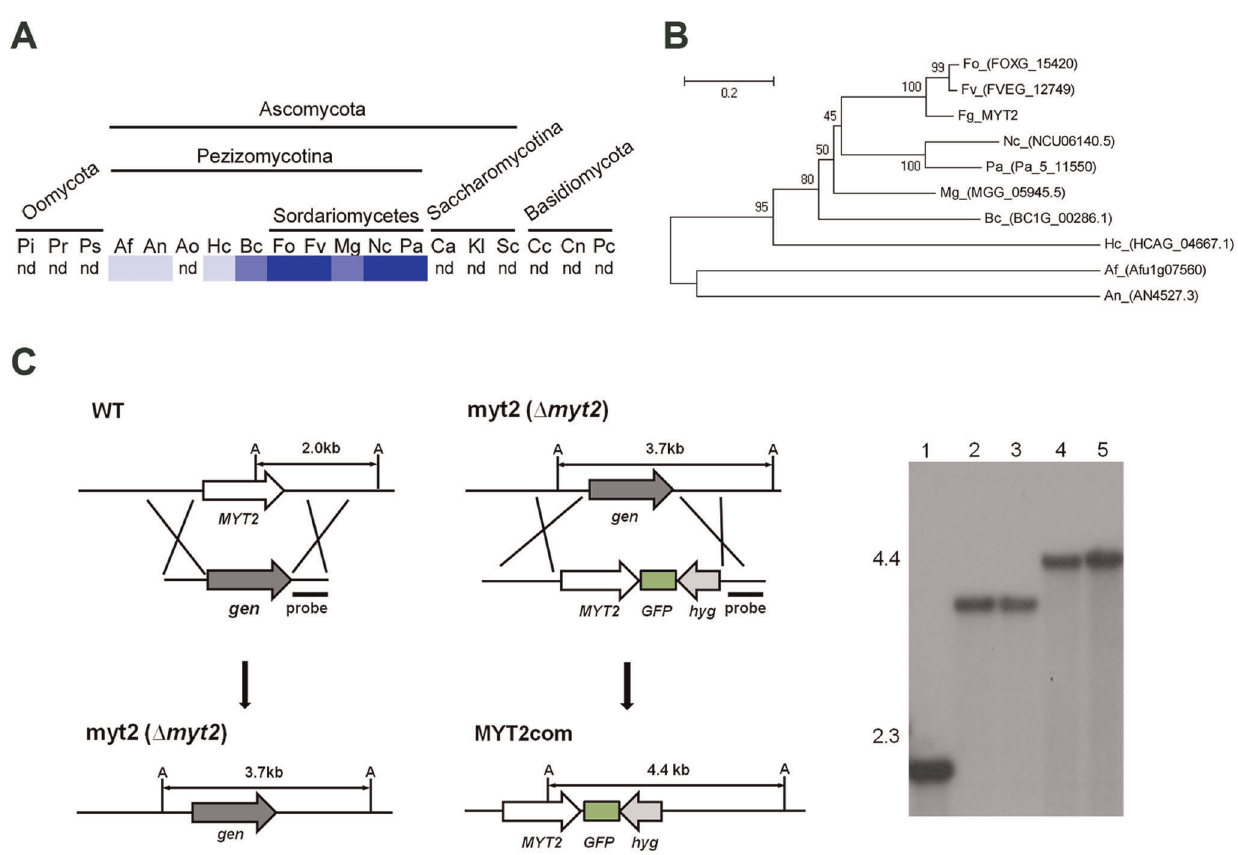
Figure 1. Distribution of MYT2 homologs in fungi and genetic complementation. (A) Distribution of MYT2 in representative fungal species. The distribution image was constructed using the BLASTMatrix tool that is available on the Comparative Fungal Genomics Platform